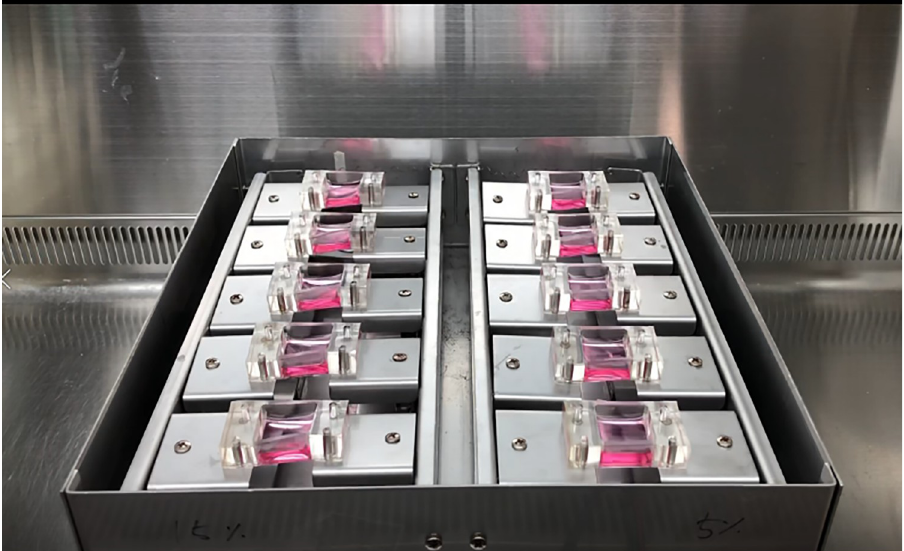
Fig 1. Novel multi-torsional mechanical stretch stress loading device. An open metal frame with multiple chambers seated parallel to the fixation panels.